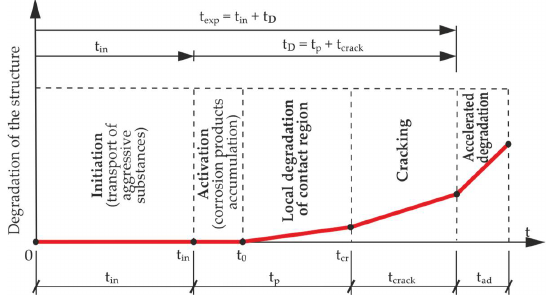
Figure 1. Scheme of degradation of the structure over